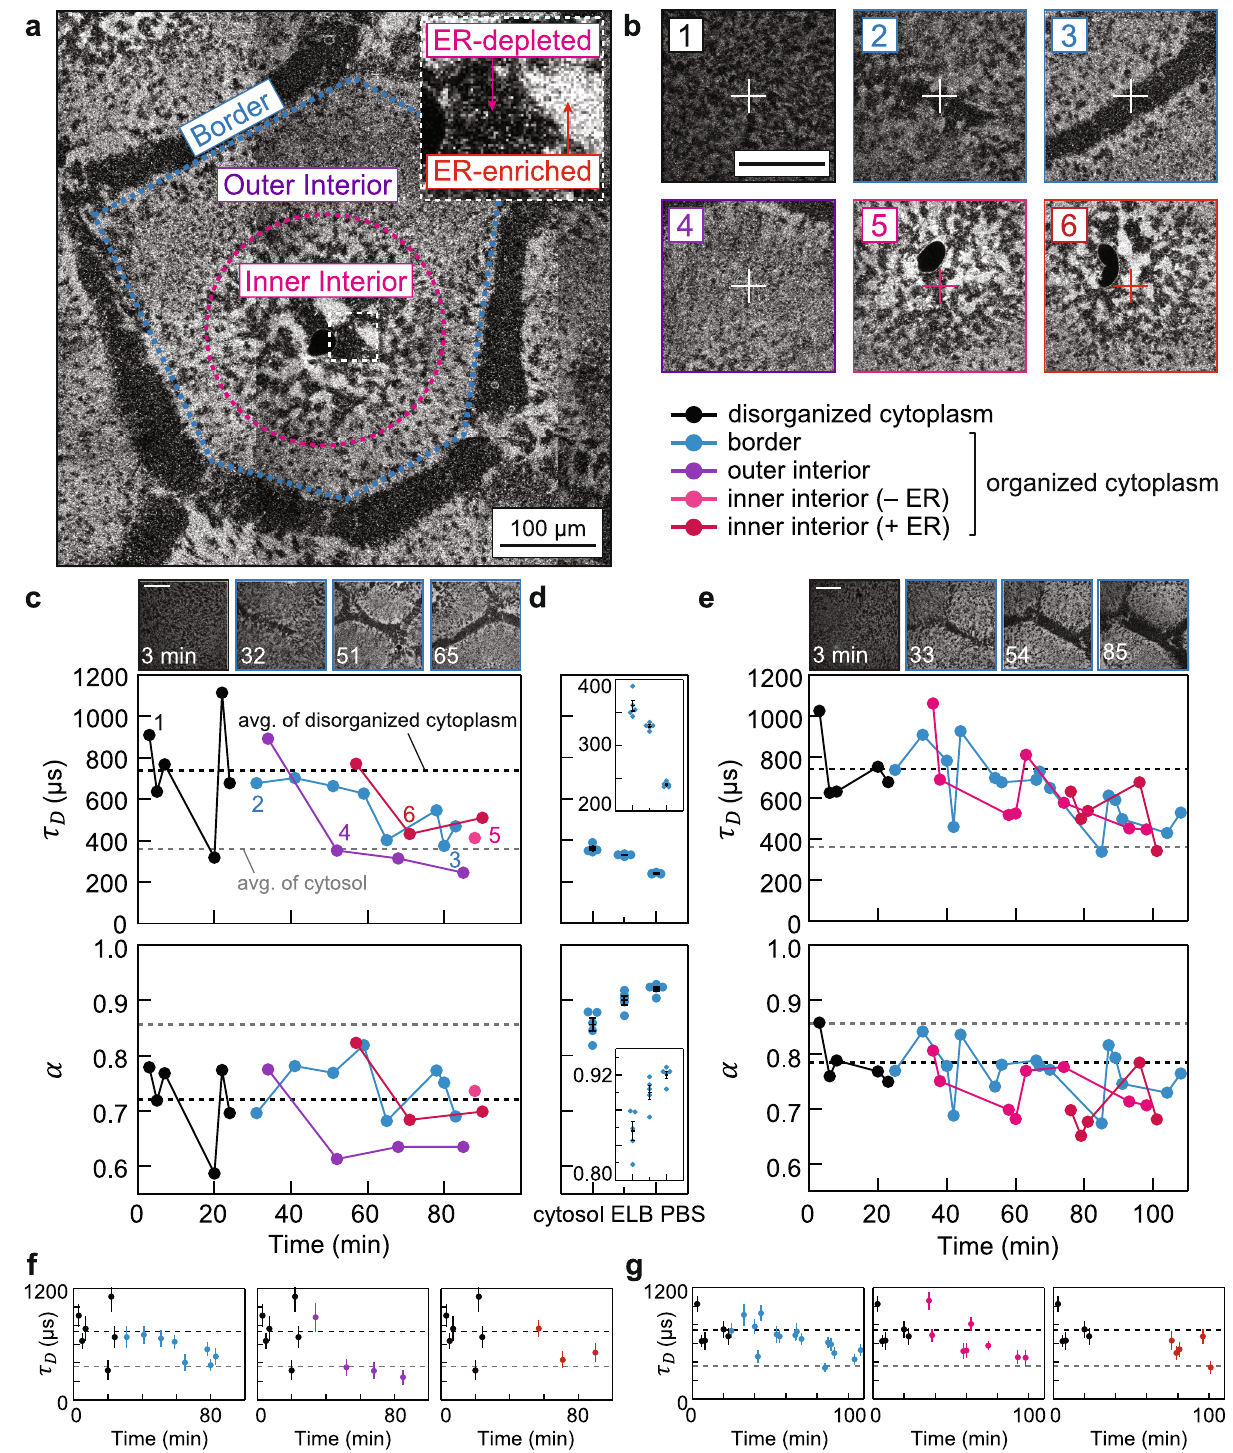
Fig. 2 | Dynamical transition of short-range diffusion in cytoplasmic extracts. a , Spatial regions of self-organization (color-coded), classi fi ed by the ER mor- phology. The dark sphere near the center of the inner interior is the nuclei. The image was stitched from multiple confocal images. b Representative confocal images of FCS foci, which are marked by the crosshairs. The annotated numbers refer to snapshots taken prior to FCS measurements in c . c Tracing protein diffu- sion during self-organization by FCS. The plots show the characteristic diffusion times τ D and the diffusion mode α obtained from fi tting the FCS curves. Black and gray dashed lines correspond to averages from disordered cytoplasmic